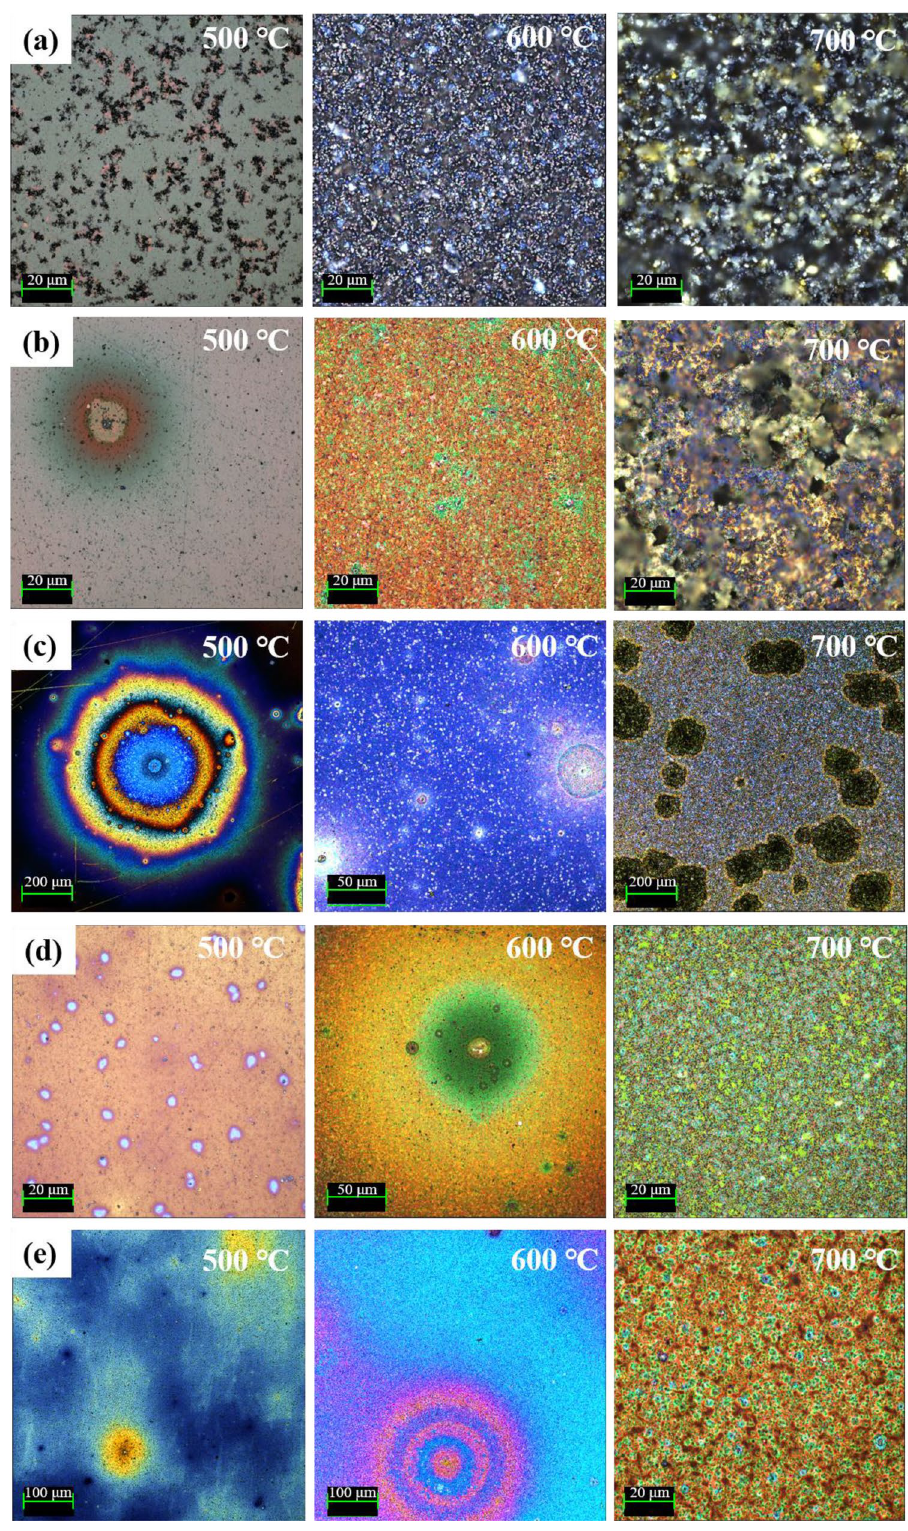
Figure 5. Surface images of tetrahedral amorphous carbon (ta-C) and Si/SiC/ta-C composite (Si–ta-C) coatings annealed at 500, 600 , and 700 °C: ( a ) ta-C coating, ( b ) 1.25 at.%, ( c ) 2.06 at.%, ( d ) 3.86 at.%, and ( e ) 6.04 at.% Si–ta-C